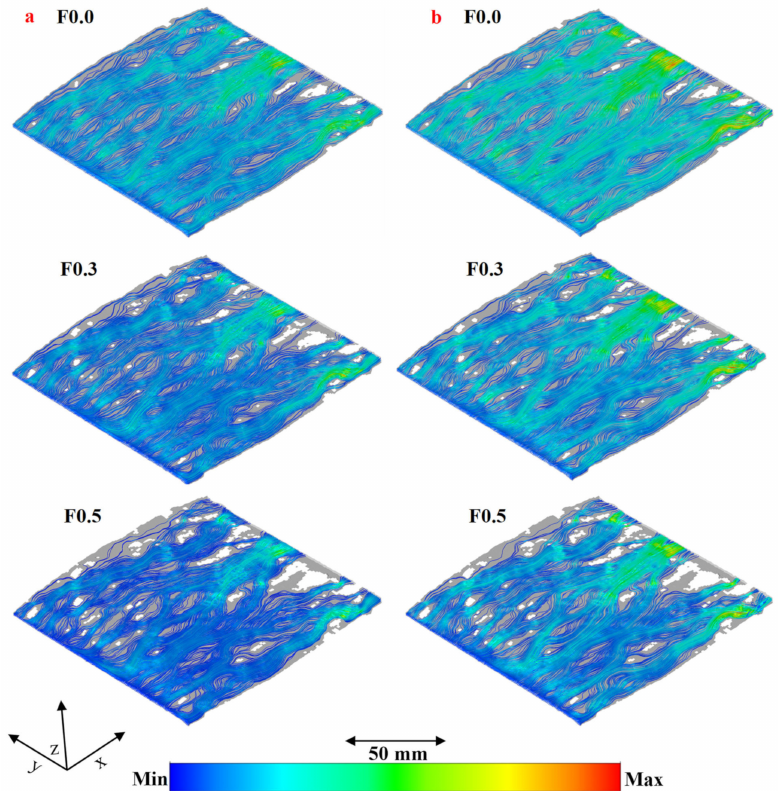
Figure 6. Flow streamlines of the three fracture cases (F0.0, F0.3 and F0.5 with different void geometries) for ( a ): R = 1 and ( b ): R = 20, where blue represents the minimum velocity and red is the maximum velocity. The grey areas are fracture voids with little flow and the white areas are surface contact areas. The inflow q for all simulations is along the x direction (after [7]).